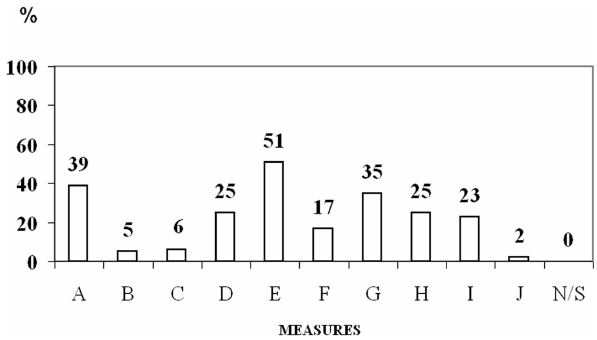
Fig. 8. Preferences for different management measures.